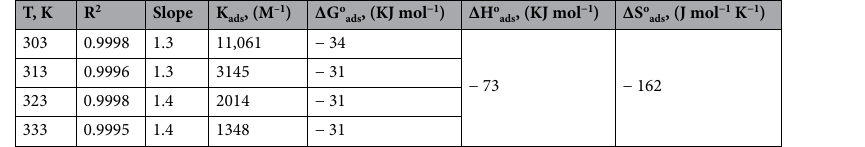
Table 3. Adsorption isotherms